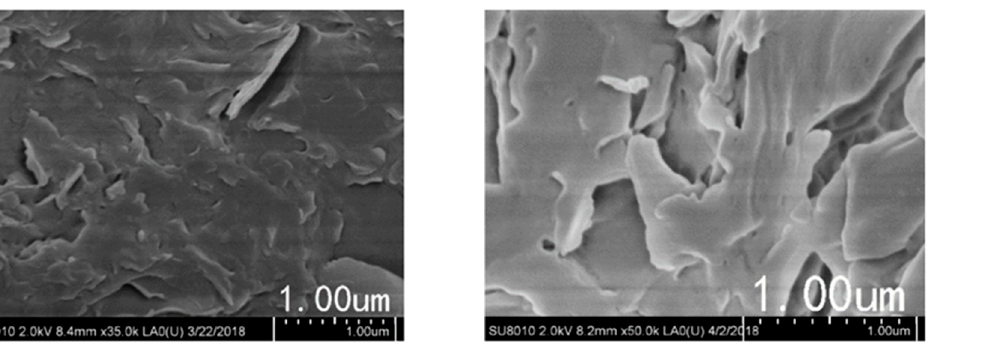
Figure 7. Effect of temperature on the viscosity of 4 wt.% DS18-3-18.